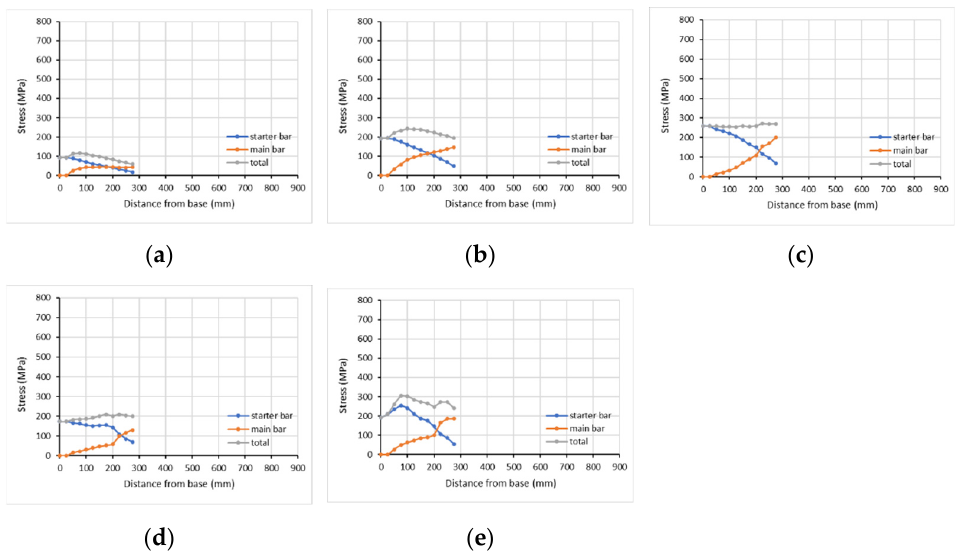
Figure 18. Developed stress along lap splice length at a displacement of ( a ) 2.24 mm, ( b ) 4.49 mm,